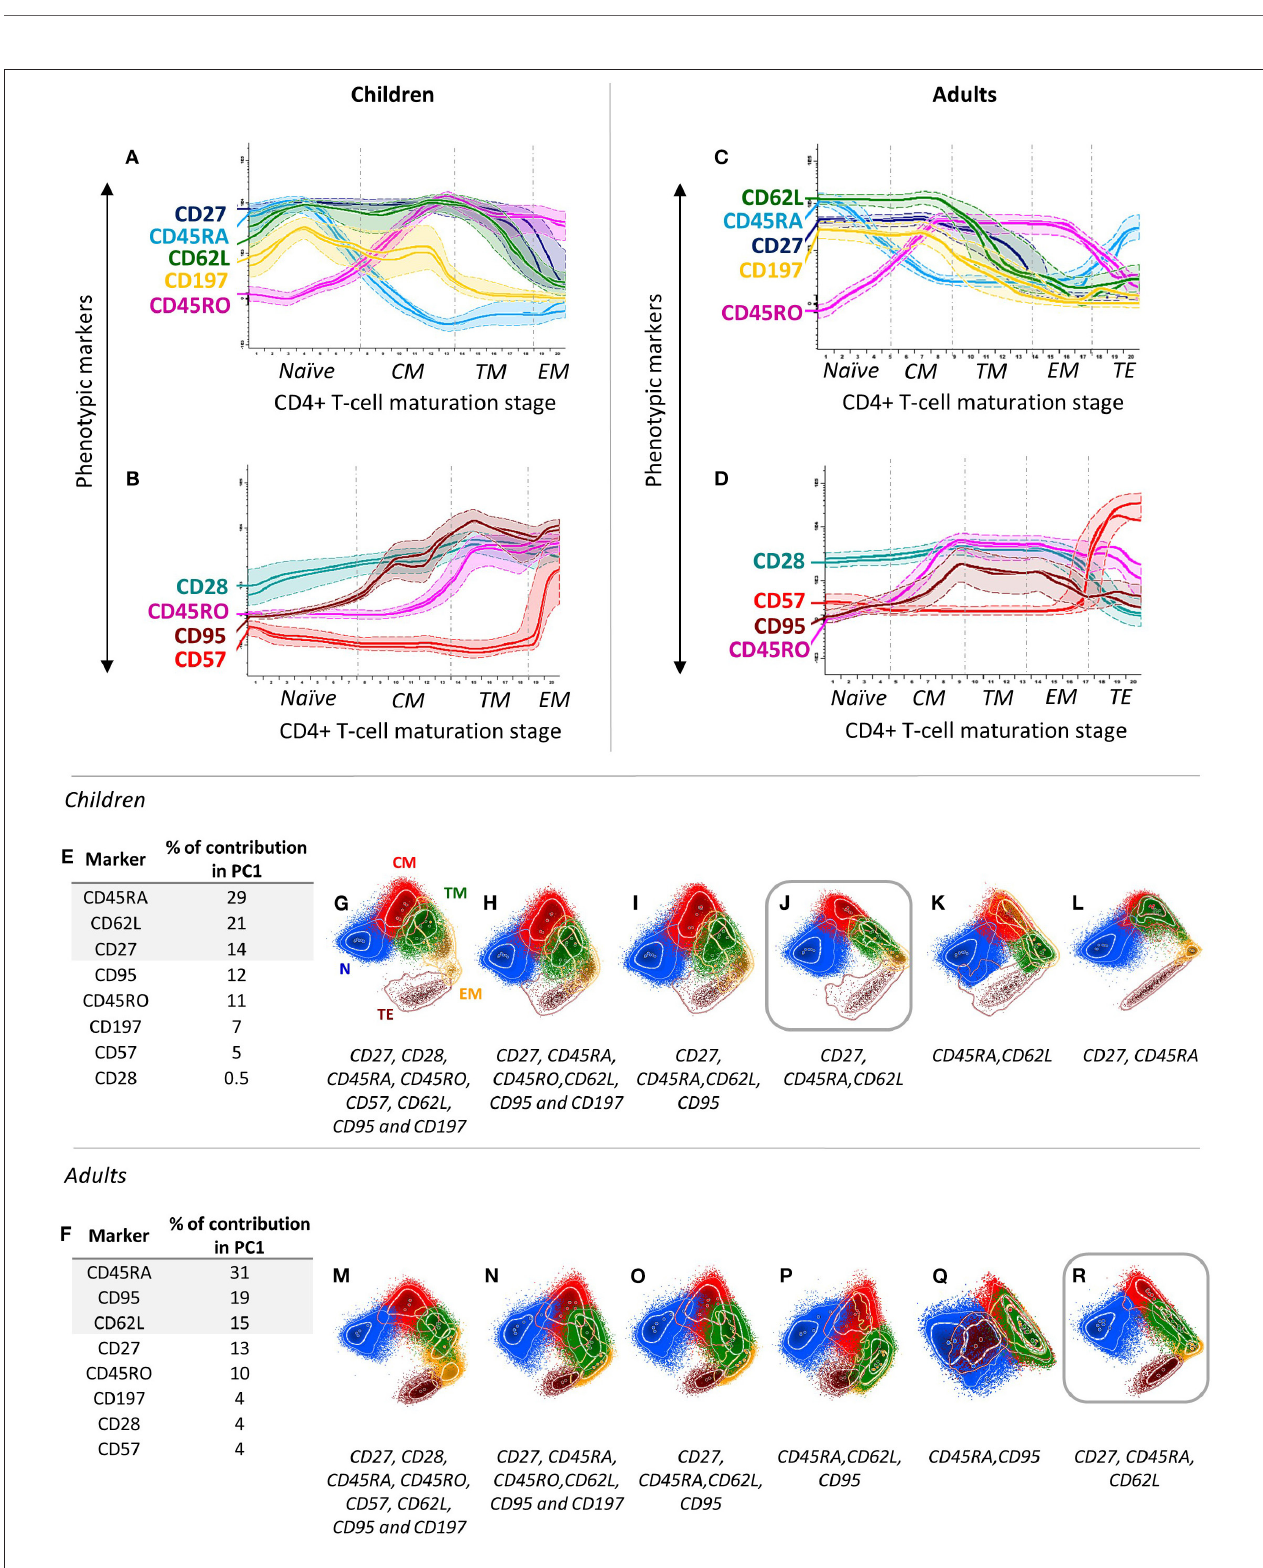
FIGURE 1 | Stepwise process used for selection and evaluation of non-redundant maturation-associated markers for inclusion in the EuroFlow immune monitoring (IMM) TCD4 tube. Redundant maturation markers (i.e., CD45RO, CD95, and CD197) were identified based on analysis of blood CD4 + T cells from two healthy children (aged 2 and 9 years) (A,B) and two healthy adults (two 40-year-old donors) (C,D) . In the maturation diagrams (A–D) , colored (solid) lines represent the level of